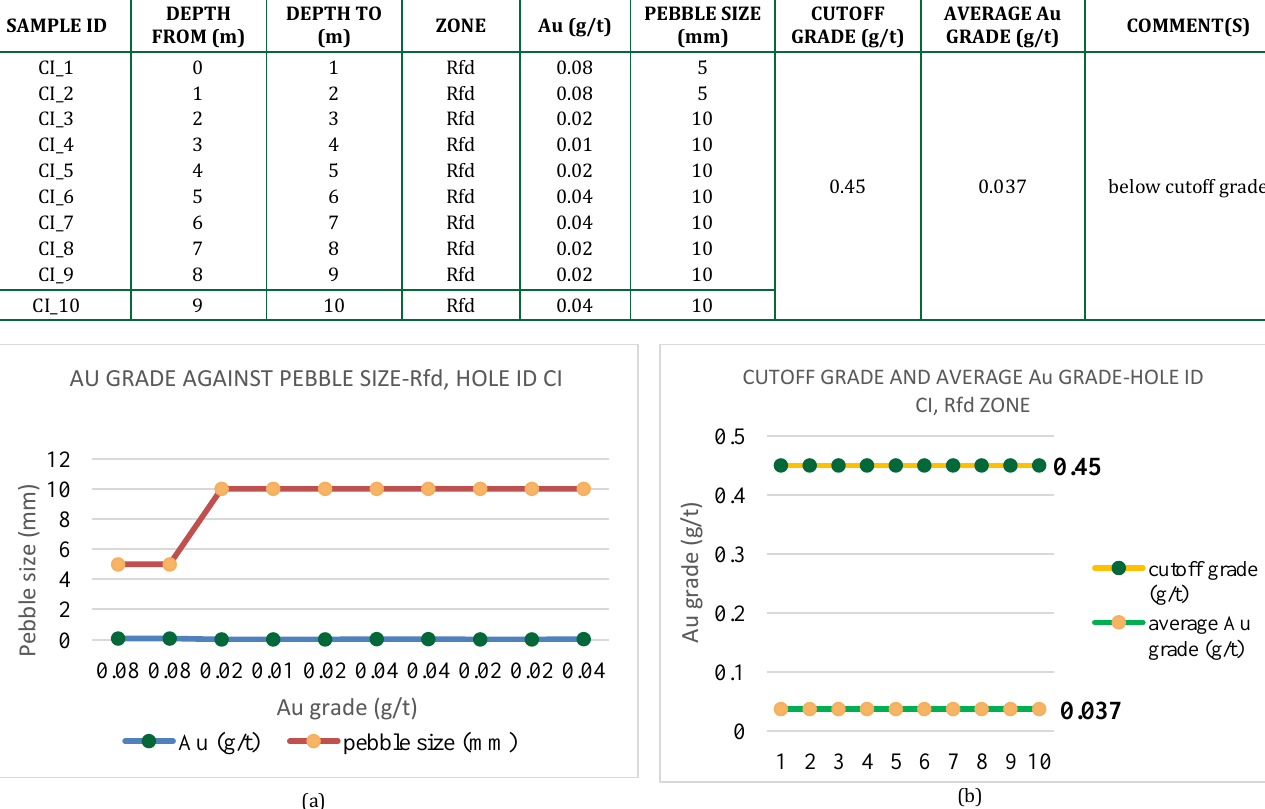
Figure 6: (a) Au grade against pebble size-Rfd, Hole ID CI; (b) Cutoff grade against average Au grade - Hole ID CI, Rfd zone